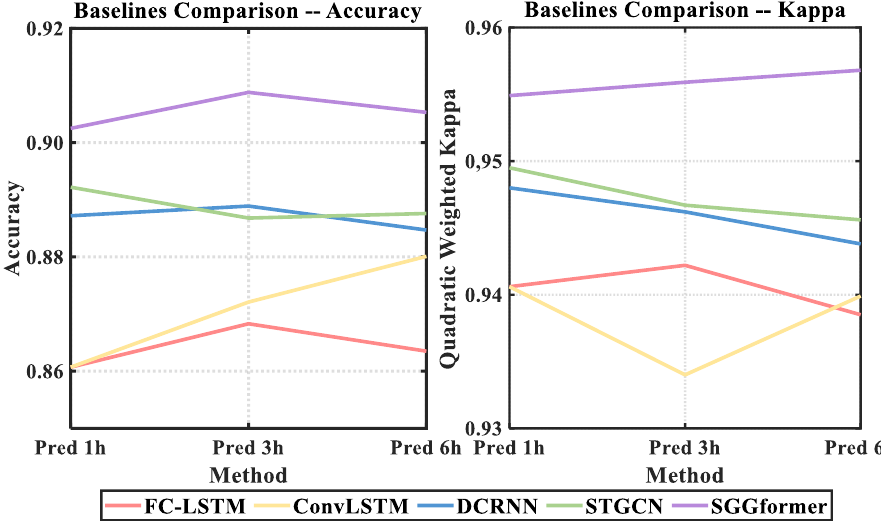
Figure 10. The performance comparison among SGGformer and